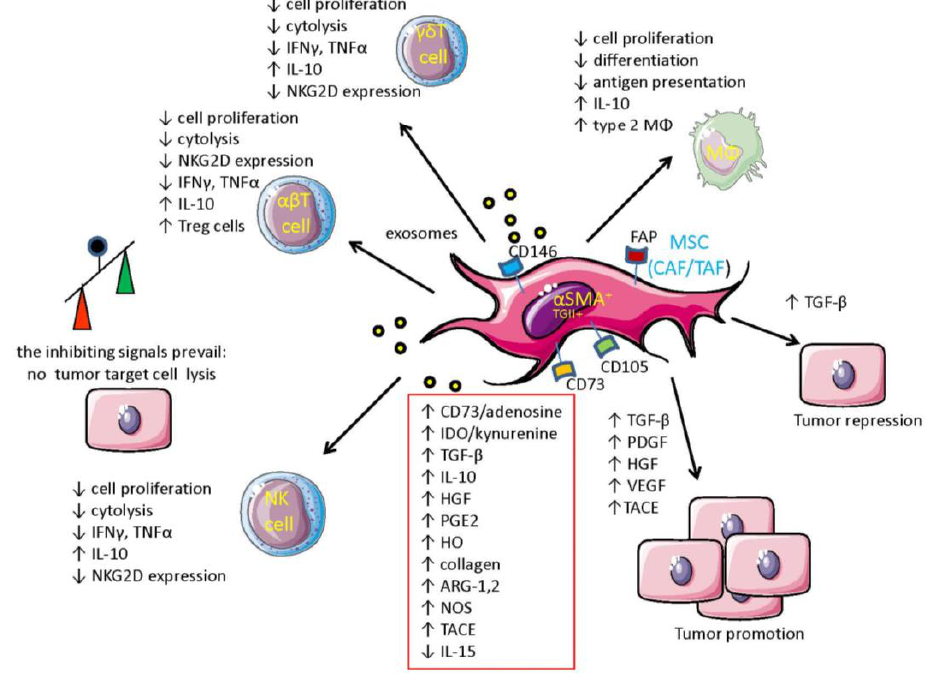
Figure 1. MSC-dependent molecular mechanisms mediating immune regulation in the tumor microenvironment and cross-talk with tumor cells. Mesenchymal stromal cells (MSC) such as cancer- or tumor-associated fibroblasts (CAF/TAF) can regulate the immune response in the tumor microenvironment (TME) by secreting a plethora of inhibitory factors (indicated in the red box). These factors can be released as soluble molecules or as a component of exosomes. These factors can inhibit cell proliferation, cytolysis, and production of anti-tumor lymphokines by effector anti-tumor lymphocytes such as natural killer (NK), αβ T, and γδ T lymphocytes. Furthermore, some of these inhibitory factor such as TGF-β can downregulate the expression of NKG2D-activating receptors, leading to the impairment of recognition and consequent killing of tumor cells expressing NKG2D-L. Overall, the inhibitory signals present in TME overcome positive signals (see the balance depicted on the left) favoring tumor cell growth. In addition, the generation of regulatory T cell (Treg) and myeloid-derived suppressor cells (MDSC) is promoted by MSC. Finally, MSC can trigger proliferation of tumor cell-secreting growth factors such as PDGF, HGF, and TGF- β . MSC, through the action of the tumor necrosis factor- α -converting enzyme (TACE), can release from the tumor cell surface amphiregulin, favoring tumor cell invasiveness. Also, VEGF produced by MSC can promote tumor tissue neovascularization. It is of note that TGF- β can function as a tumor suppressor rather than a tumor